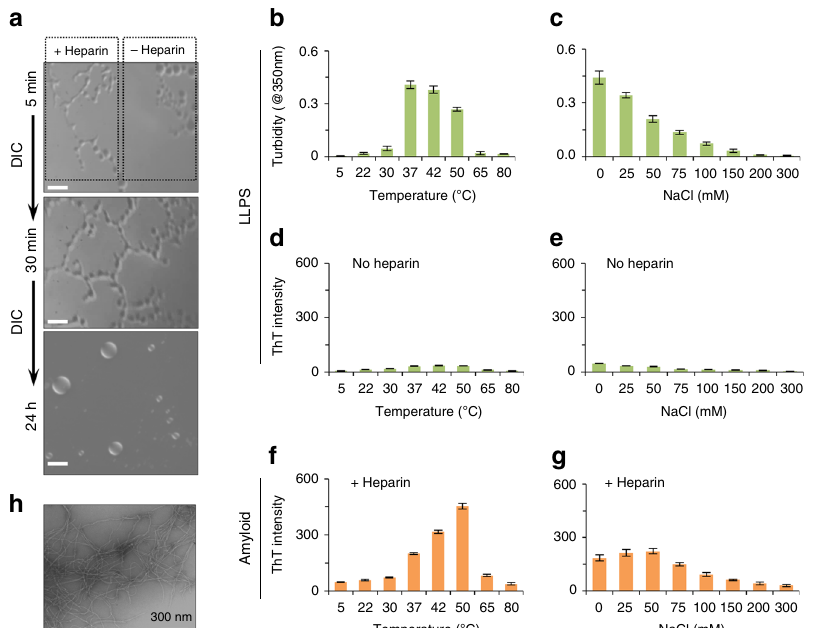
Fig. 6 LLPS of the repeat domain of Tau promotes fi brillization in presence of the polyanion heparin. a Addition of heparin to K18 droplets (100 μ M of K18 in 50 mM sodium phosphate; 0.5 mM TCEP; pH 8.8; 37 °C; K18:heparin molar ratio of 4:1) results in formation of a phase-separated mesh. DIC micrographs show that the region, to which heparin was added (shown along dotted lines ; +heparin), changes fi rst. After 24 h, the mesh has dissolved and larger liquid droplets were observed. Scale bars correspond to 10 μ m. b , d In fl uence of temperature on turbidity ( b ) and ThT fl uorescence ( d ) of a K18 solution (100 μ M K18 in 50 mM sodium phosphate, 0.5 mM TCEP, pH 8.8) in the absence of heparin. Prior to turbidity measurements, solutions were incubated at the speci fi ed temperature for 6 h. Error bars in b – g represent SEM of three independent measurements. c , e Ionic strength dependence of turbidity ( c ) and ThT fl uorescence ( e ) of heparin-free K18 solutions (100 μ M K18 in sodium phosphate, 0.5 mM TCEP, pH 8.8). Prior to turbidity measurements, solutions were incubated at 37 °C for 24 h. f Temperature-dependence of amyloid formation of K18 (100 μ M K18 in 50 mM sodium phosphate, pH 8.8) in the presence